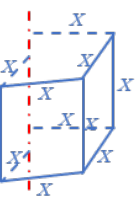
Figure 23: Unlike the smooth screw dislocation, the cube terms in a rough screw dislocation are not all locally homeomorphic to a simple cubic cell. This figure shows the structure of the cube term adjacent to the dislocation (denoted by the red dotted line). All the vertex terms are locally homeomorphic to a vertex in a simple cubic µ lattice, so we use the natural definition of B in that case. There are no vertex terms v on the dislocation line.